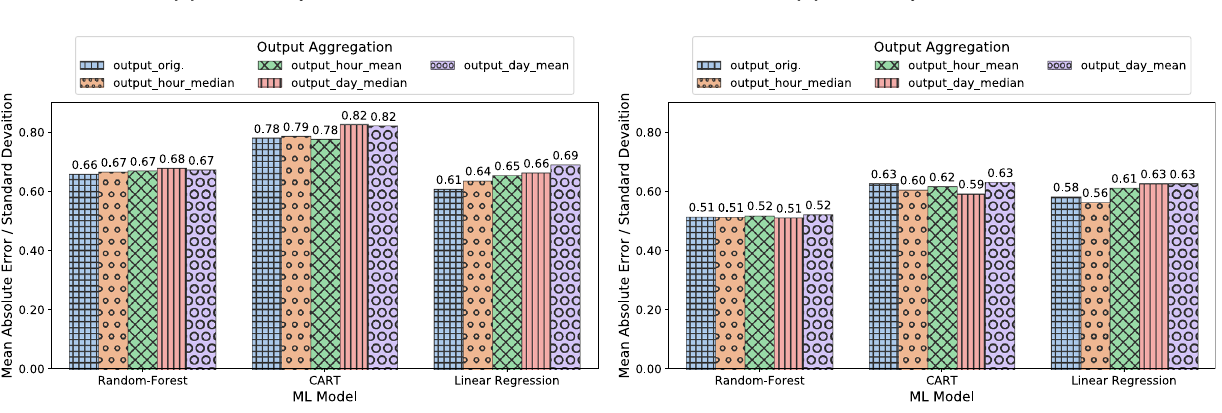
Figure 6. Comparison of output features aggregation with ML models: Beach buoy in terms of MAE ( a ) ); Dam buoy in terms of MAE ( b ); Beach buoy in terms of F1 ( c ); Dam buoy in terms of F1 ( d ); Beach buoy in terms of MAE/STD ( e ); Dam buoy in terms of MAE/STD ( f